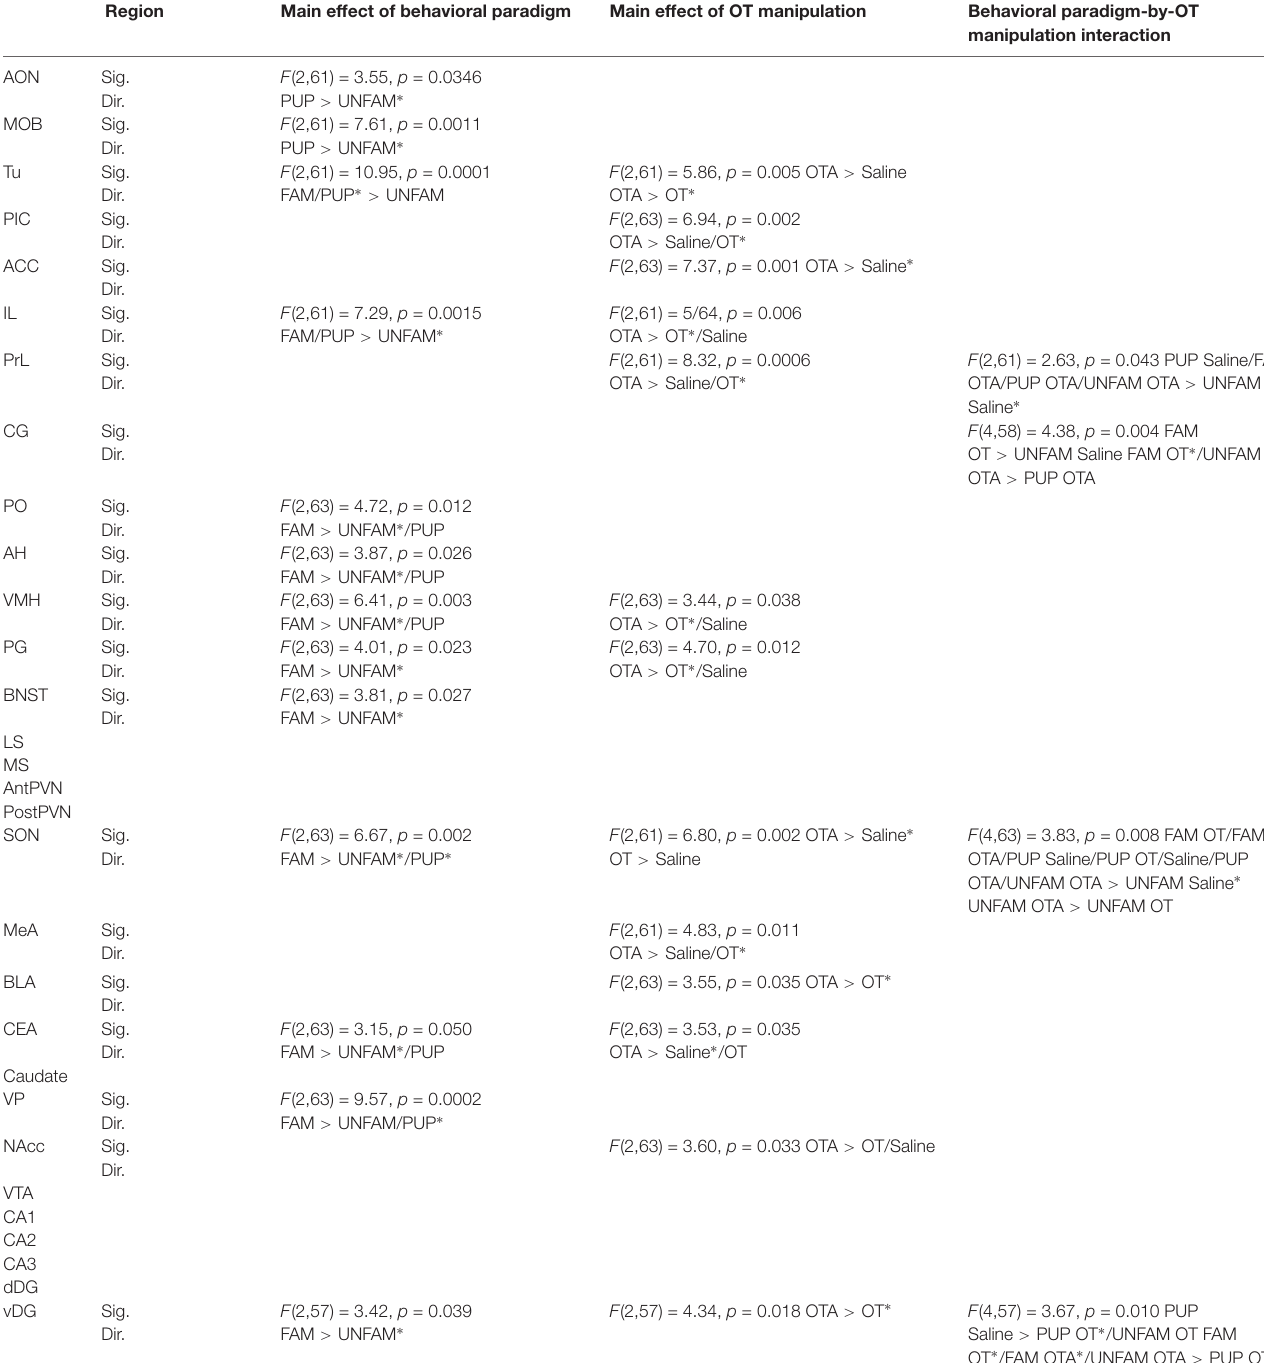
TABLE 2 | Brain region-specific linear mixed effect model results listed by brain region with significance value (Sig) and direction of effect (Dir).